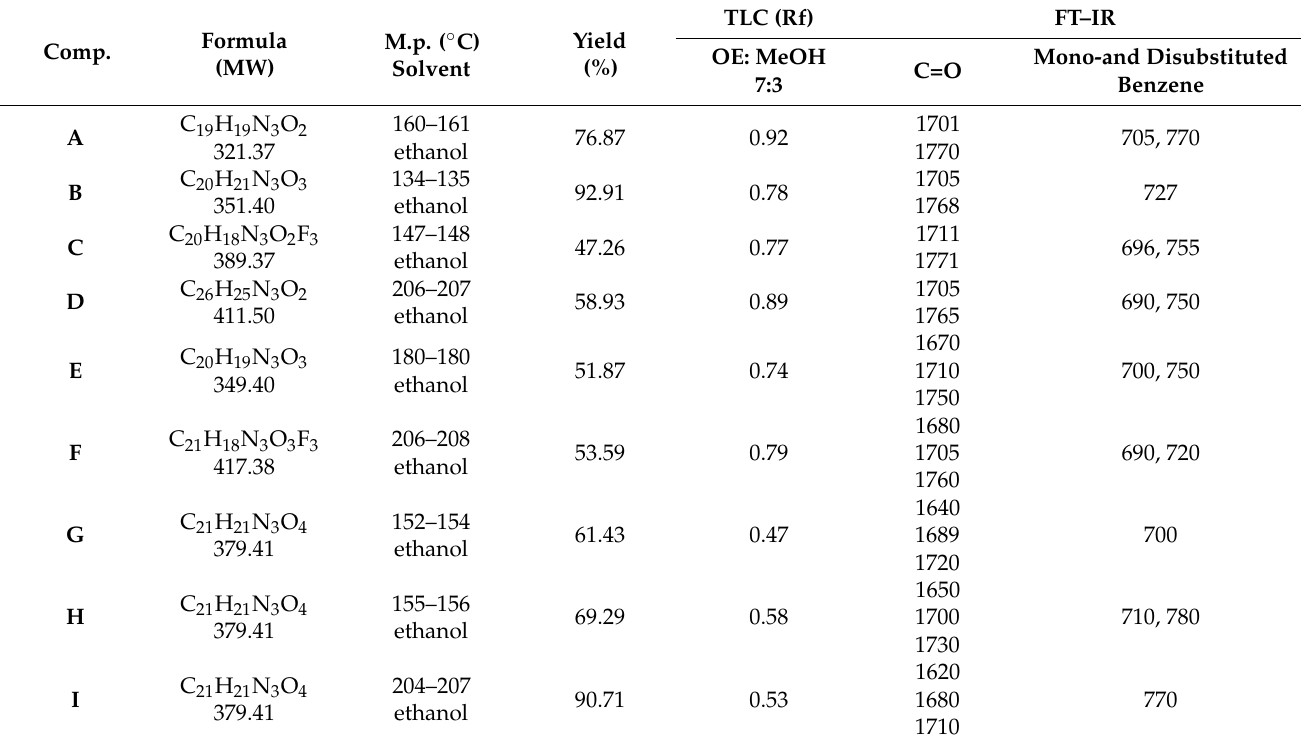
Table 5. The properties of obtained compounds A – I